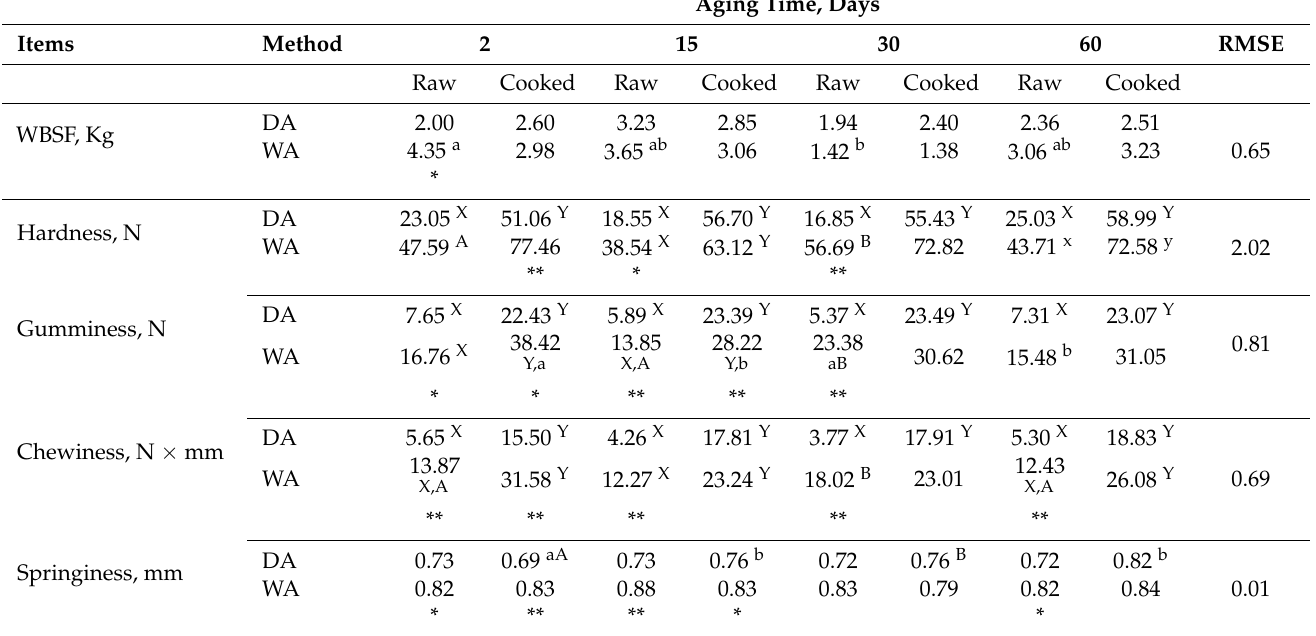
Table 4. Changes in texture profile analysis (TPA) and Warner–Bratzler shear force (WBSF) as a func- tion of the aging method and time in Charolais meat cuts ( Longissimus dorsi (LD) and Semitendinosus (ST)) aged by different methods (dry-aging (DA) and wet-aging (WA)) for 60 days. Aging Time,